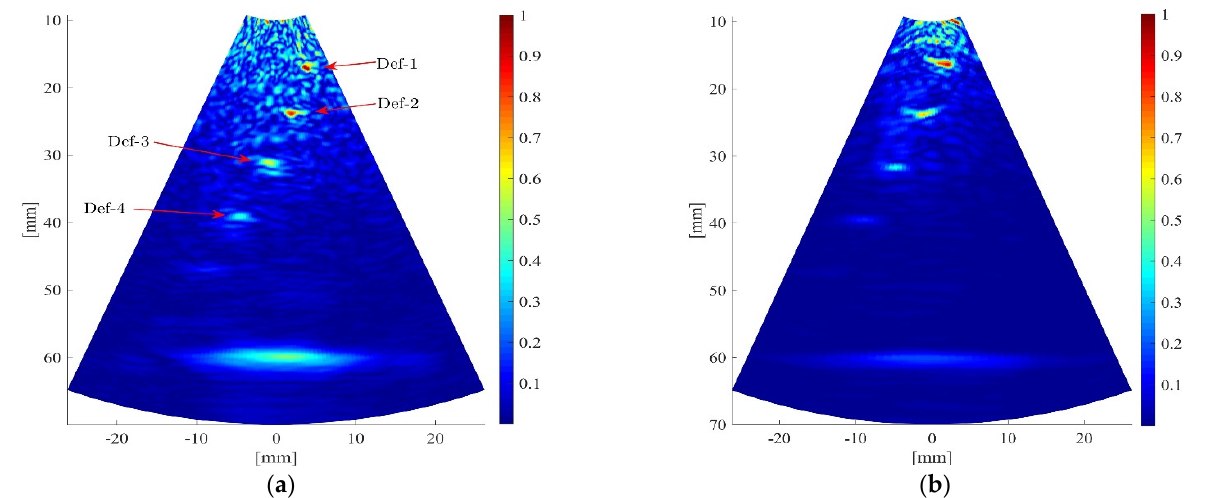
Figure 5. Sector scan images of the CFRP sample obtained by using the full aperture of the UT array transducers; ( a ) image obtained with the pulse-compression-based system and ( b ) image obtained using with the pulse-echo system.